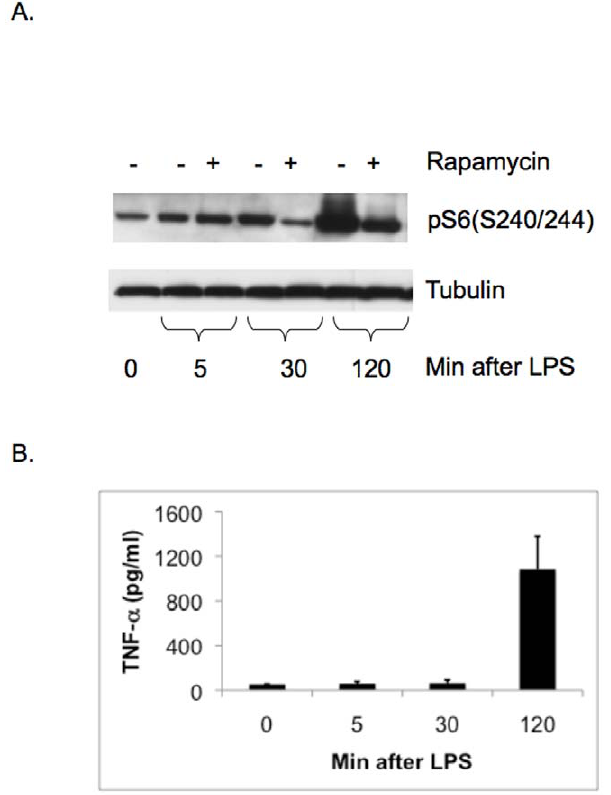
Figure 9. PI3K-Akt inhibition did not effect LPS-induced mTORC1-S6K activation. RAW cells pre-treated with 100 nM wortmannin, 12.5 m M LY294002, or vehicle control prior to 100 ng/ml LPS challenge were collected 2 hr post LPS. Representative immuno- blots demonstrating successful suppression of p-Akt with wortmannin or LY294002 did not affect mTORC1-S6K activation as assessed by pS6 levels. Activation of ERK was also not affected by these compounds.